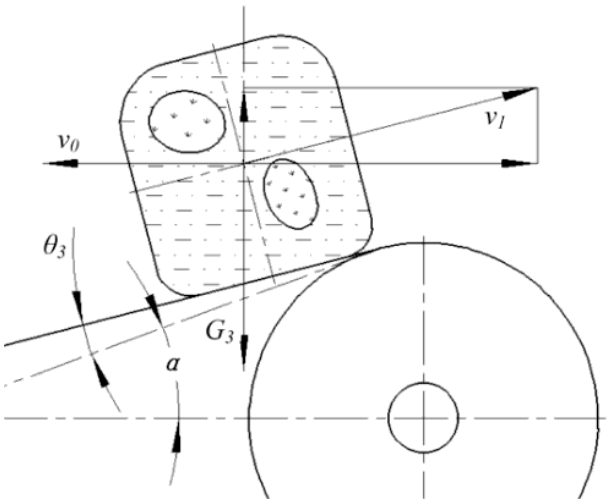
Figure 5. Analysis of the throwing process of potato-soil mixture. The throwing height was yielded from Equation (7):